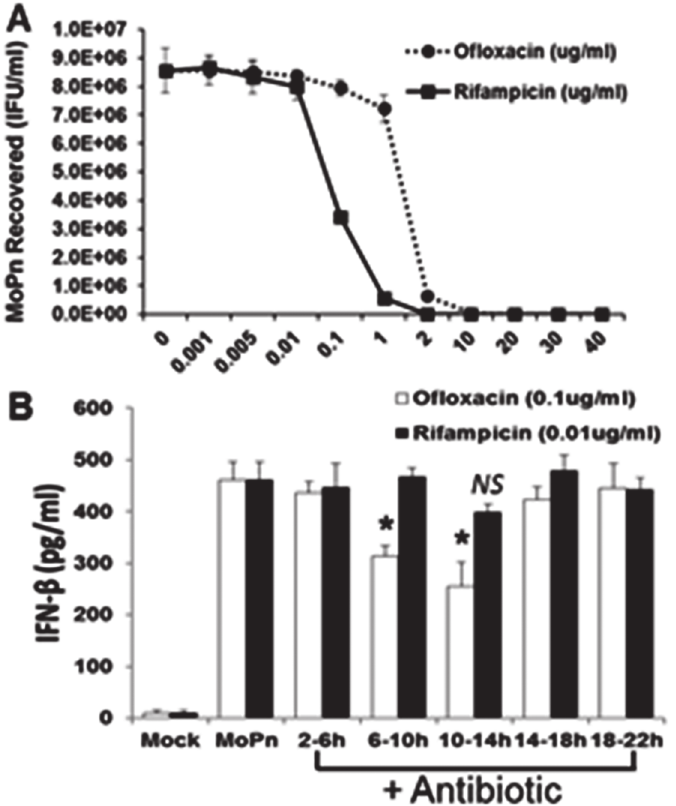
presence of increasing concentrations of either rifampicin or ofloxacin starting at 2h PI. The medium was replaced with antibiotic-free medium at 18h PI, cells were harvested at 30h PI, and C . muridarum titers (IFU/